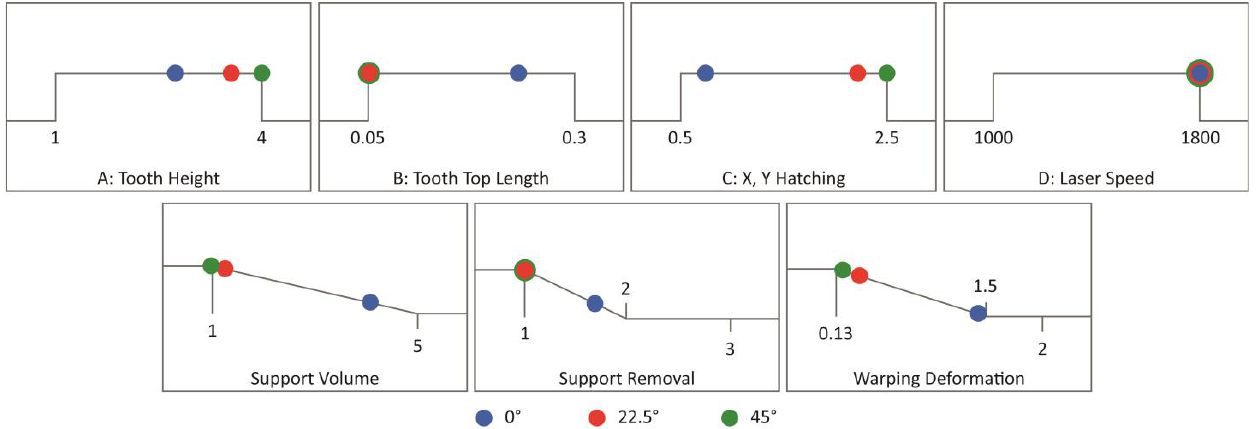
Figure 12. Graphical representation of the selected optimal solutions for 0°, 22.5°, and 45° over- hangs.